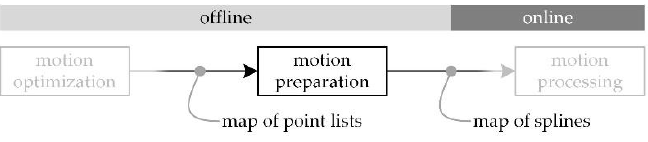
Figure 2. Position of the motion preparation in the workflow.